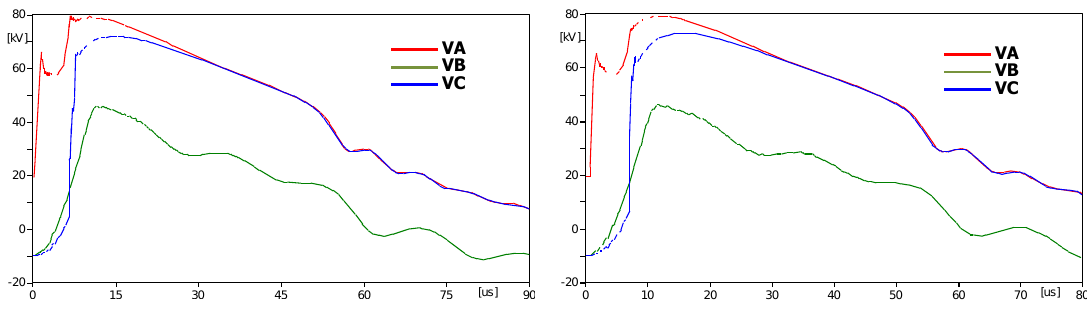
Figure 42. A 100 m underground cable.